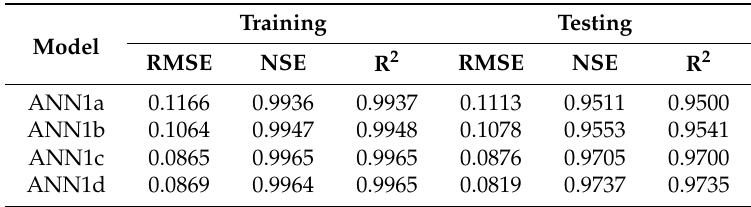
Table 5. Statistical measurement of 1 h forecasts for 5% highest water level